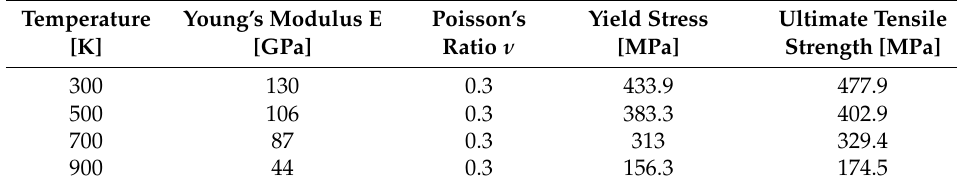
Table 4. Mechanical properties of CuCrZr alloy [5].